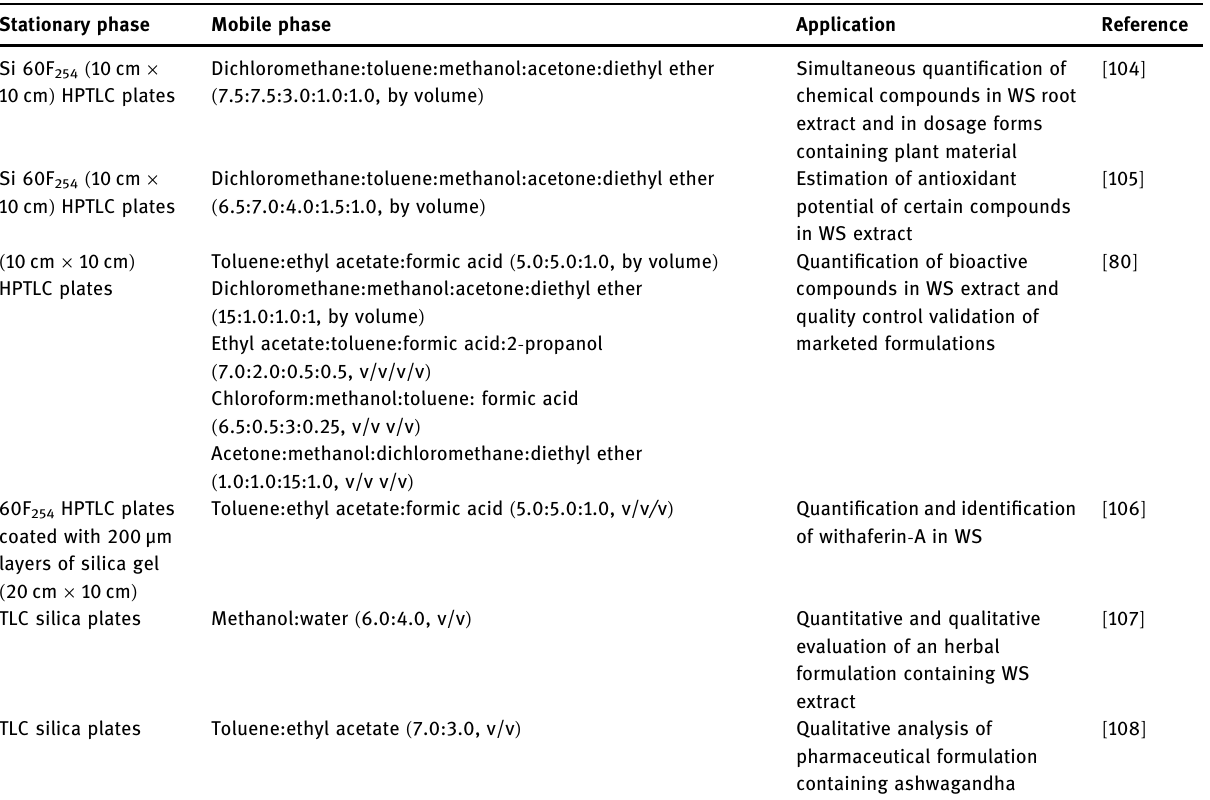
Table 6: Summary TLC and HPTLC methods for the analysis of WS active constituents Stationary phase Mobile